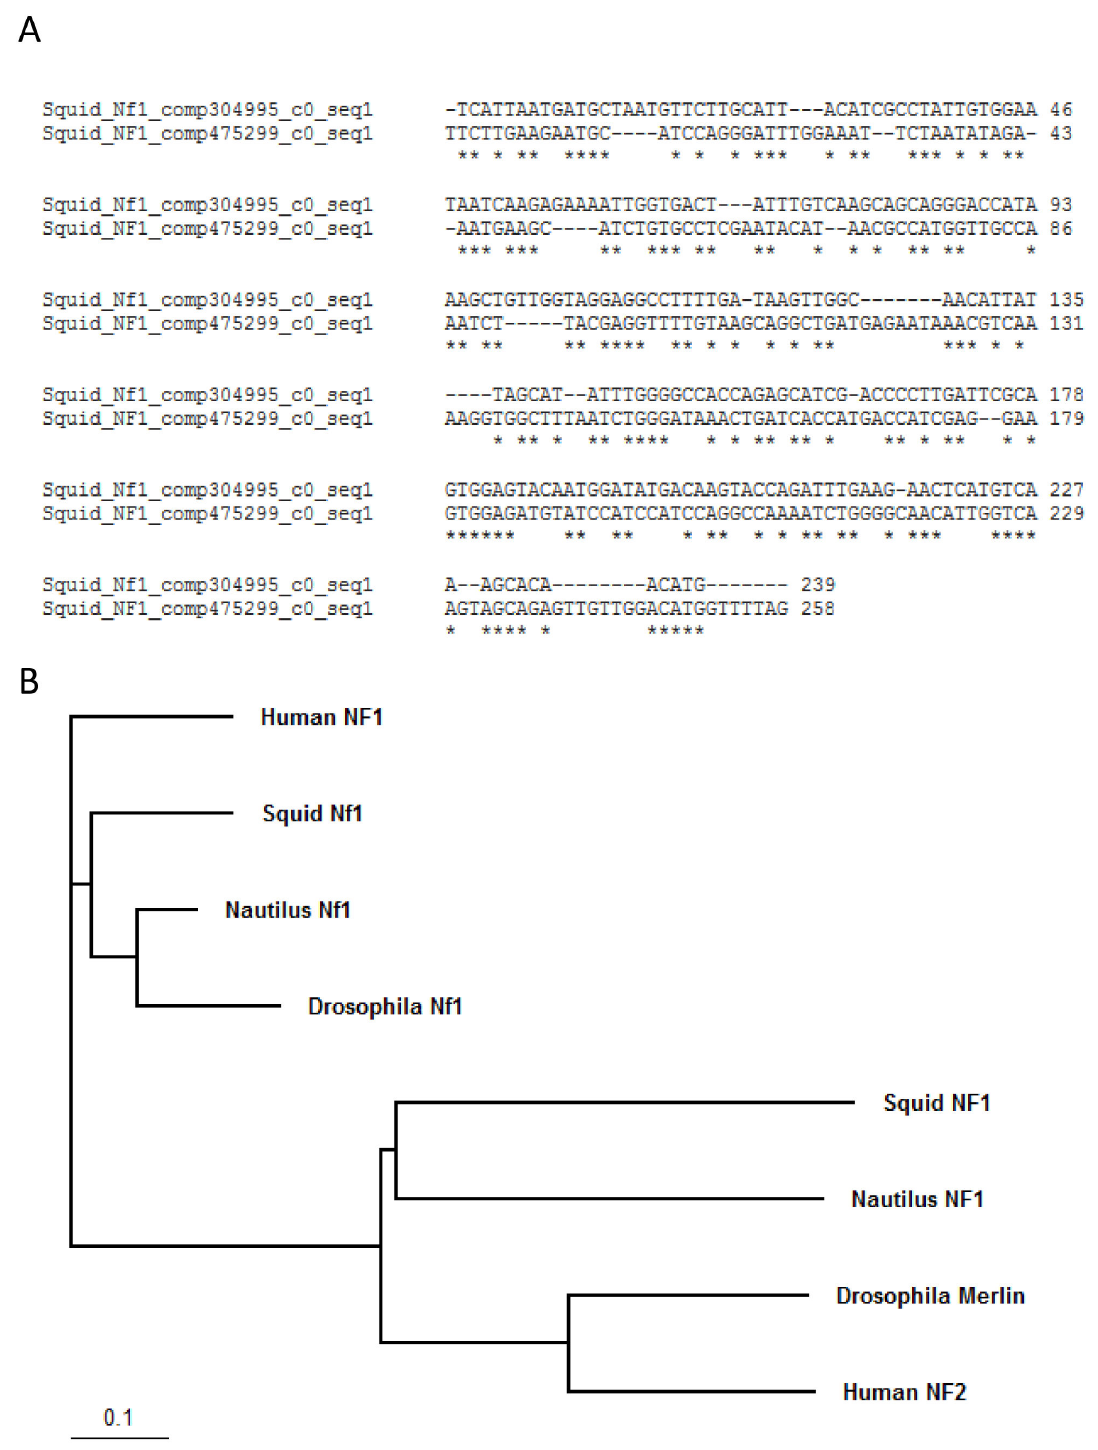
Figure 8. NF1/Nf1 sequence comparisons. A. Nucleotide sequence alignment using ClustalW2 of squid contigs that were found from this analysis indicate potential gene duplication of NF1/Nf1 in cephalopods. Comp304995_c0_seq1 has best hit with Drosophila Nf1 and comp475299_c0_seq1 with Human NF1. Asterisk(*) indicate sequence identity. B. Phylogenetic tree using Human NF1 and NF2, Drosophila Nf1 and Merlin as well as Nautilus and squid NF1/Nf1 contigs. Note that Nautilus and squid NF1 contigs, and Nautilus and squid Nf1 contigs cluster together. Bar indicates phylogenetic distance. doi: 10.1371/journal.pone.0078054.g008 PLOS ONE |